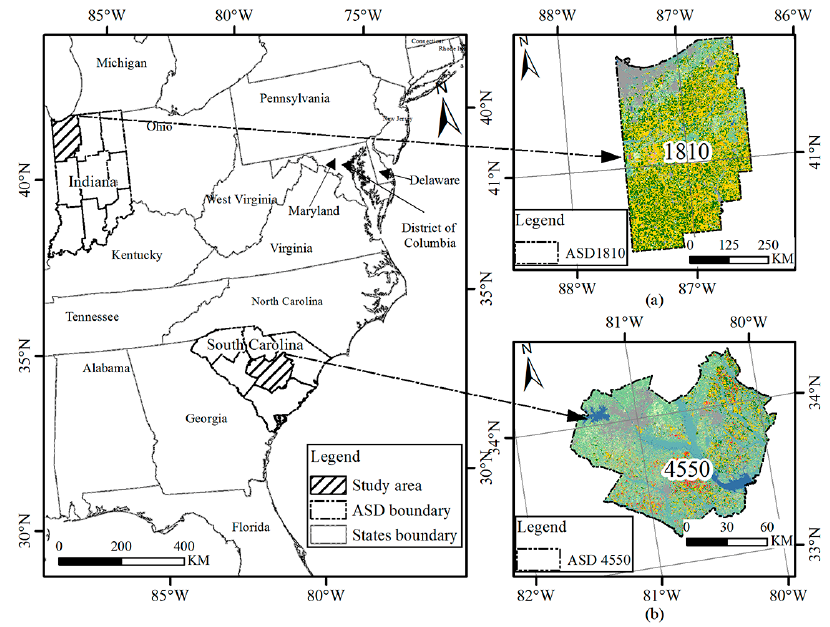
Figure 1. Study areas: ( a ) Agricultural Statistics District (ASD) 1810 in Indiana; and ( b ) ASD4550 IN South Carolina. Table 1. Landscape characters of the study areas. All landscape metrics were produced by Fragstats version 4.2, a spatial analysis software package for computing landscape metrics. TA means total area. NP means number of patches, LPI means largest patches index, AI means aggregation index. Dominance measures the extent to which one or a few classes dominate the landscape. PPU is a measure of fragmentation. Square-pixel index (SqP) measures the complexity of landscape. More details about these landscape metrics can be found in Section